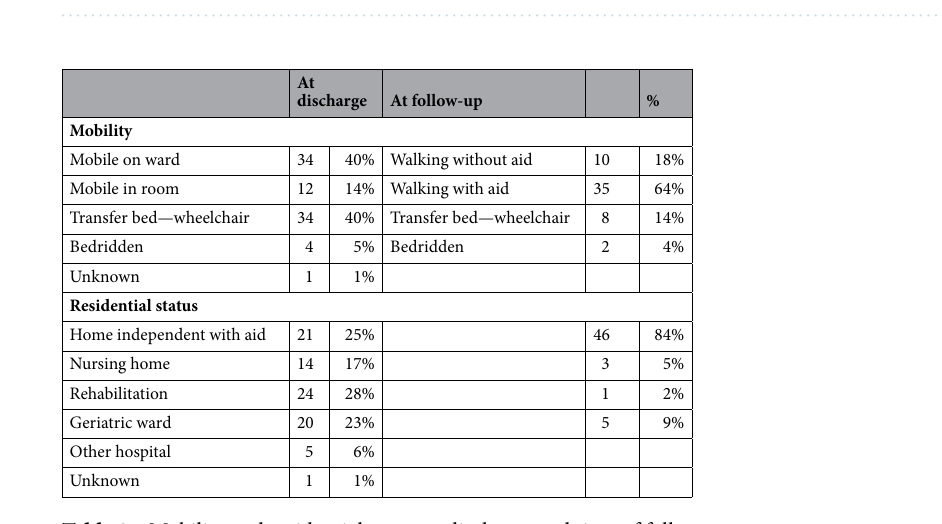
Table 2. Detailed operative treatment of posterior and anterior pelvis. TB trans-sacral bar; IS ilio-sacral.